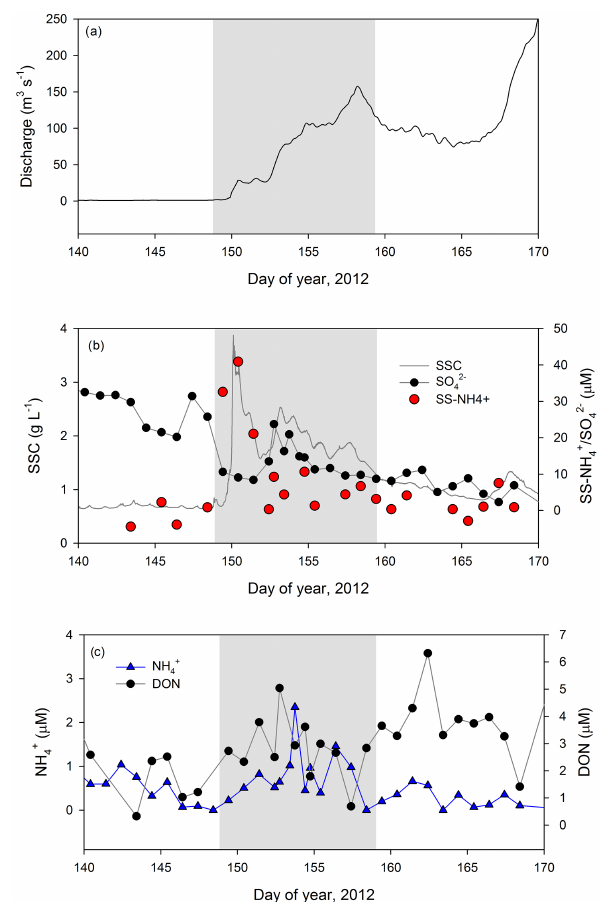
Figure 6. Times series of (a) bulk discharge, (b) concentrations of ) and dissolved sulfate, and (c) con- sediment-bound NH + (P-NH + 4 4 centrations of DON and dissolved NH + in runoff measured during 4 the first (and main) subglacial outburst event during the 2012 sea-